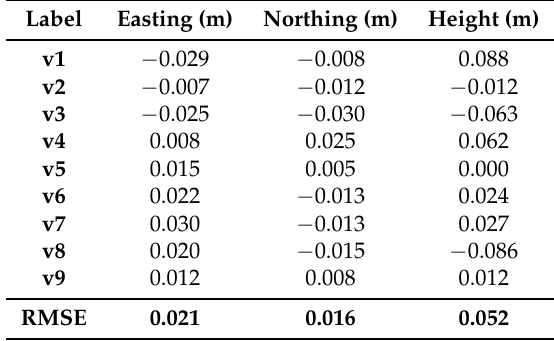
Figure 3. Vineyard site: DSM ( a ) and orthophoto ( b ) produced through photogrammetric processing of the RGB dataset; false color orthophoto ( c ), generated from the multispectral dataset. Table 1. Vineyard site: residuals on the GCPs after bundle block